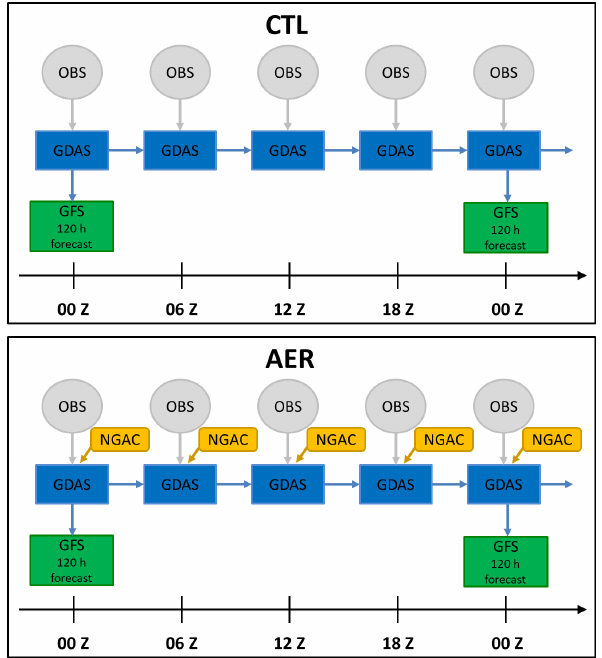
Figure 1. Schematic flowchart of the aerosol-blind (CTL) and aerosol-aware (AER) experiments in this study. See Sect. 2.1 for